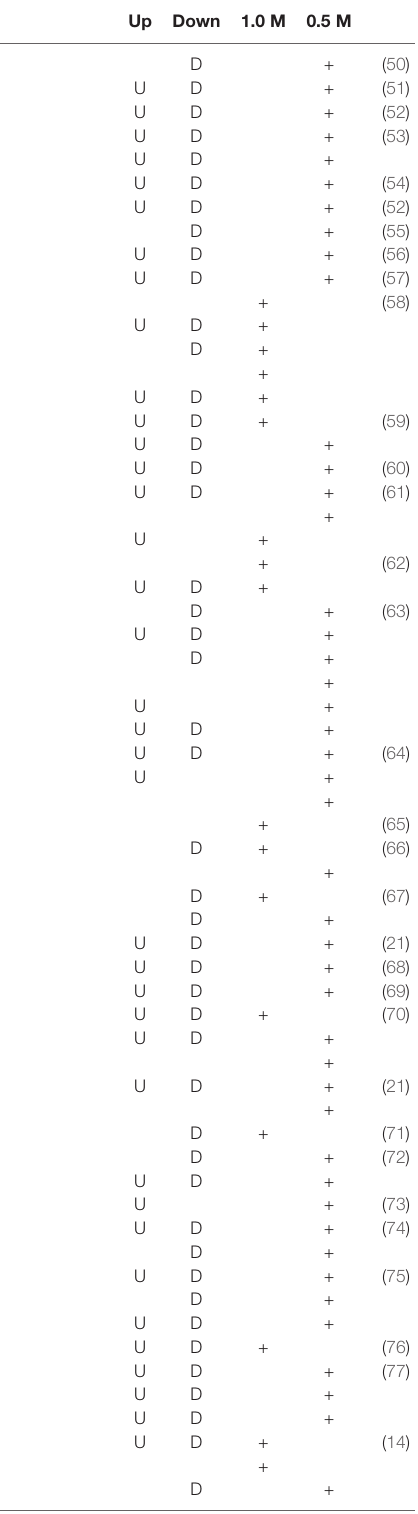
TABLE 1 | DS-af fi nity enriched autoantigen-ome from human HFL1 cells. # Pep. Gene